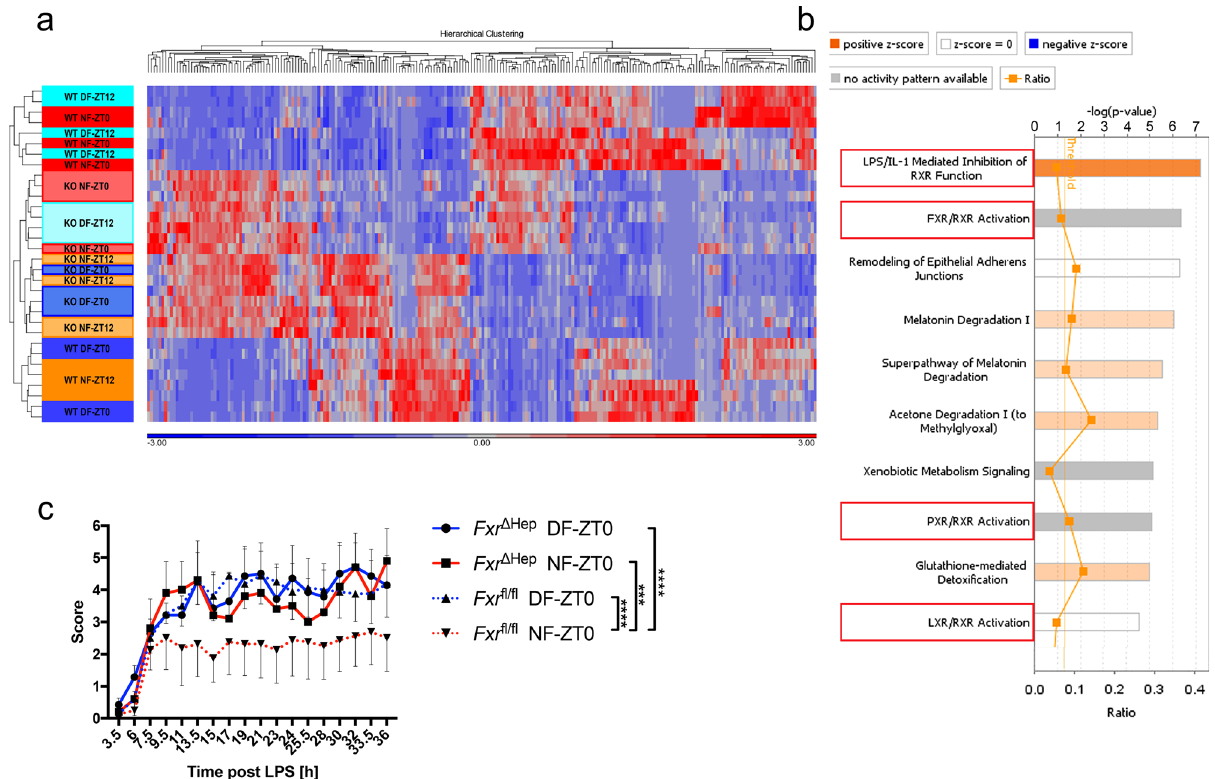
Fig. 6 Hepatic FXR regulates early susceptibility to LPS. a One-way ANOVA comparison performed on Log2 transformed RPKM values of Bmal1 fl / fl and Bmal1 Δ Hep liver on day 5 of TRF at ZT0 or ZT12 as indicated, comparing resistant groups ( Bmal1 fl / fl NF0 and Bmal1 fl / fl DF12) vs. susceptible groups ( Bmal1 fl / fl NF12, Bmal1 fl / fl DF0 and all Bmal1 Δ Hep groups). Relative expression for genes that were expressed in at least one animal, a FDR<0.2, and two-fold changed between resistant vs. susceptible groups (232) are shown in the Heatmap indicating relative expression (RPKM-mean RPKM/standard deviation) for each gene. b Core analysis using IPA of genes that were expressed in at least one animal, a FDR<0.2, and two-fold changed (232) in a one-way ANOVA comparison performed on Log2 transformed RPKM values of Bmal1 fl / fl and Bmal1 Δ Hep liver on day 5 of TRF at ZT0 or ZT12 as indicated, comparing resistant groups ( Bmal1 fl / fl NF0 and Bmal1 fl / fl DF12) vs. susceptible groups ( Bmal1 fl / fl NF12, Bmal1 fl / fl DF0 and all Bmal1 Δ Hep groups). Top 10 canonical pathways are shown. N = 4. c Clinical score of day-time and night-time fed Fxr Δ Hep (solid line) or Fxr - fl oxed control female mice (dotted line) following 20mg/kg LPS i.p. stimulation